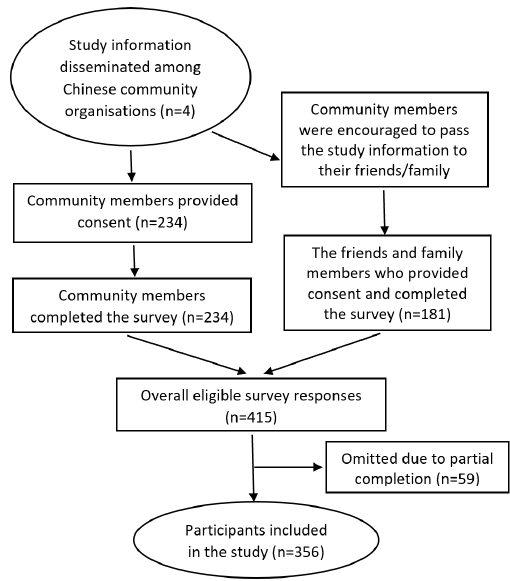
Figure 1. Study recruitment